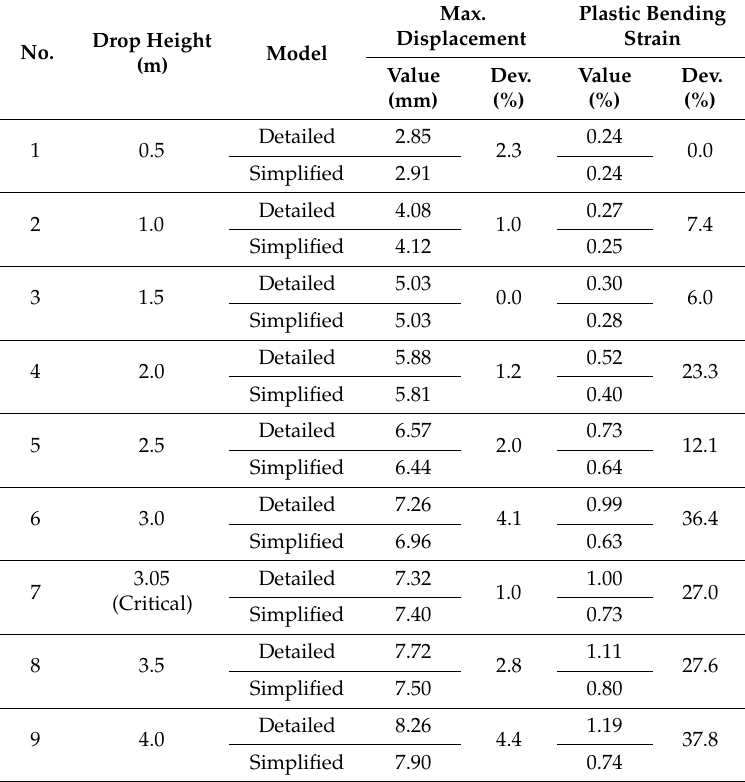
Table 6. Results of the impact analyses for the fully bonded case.